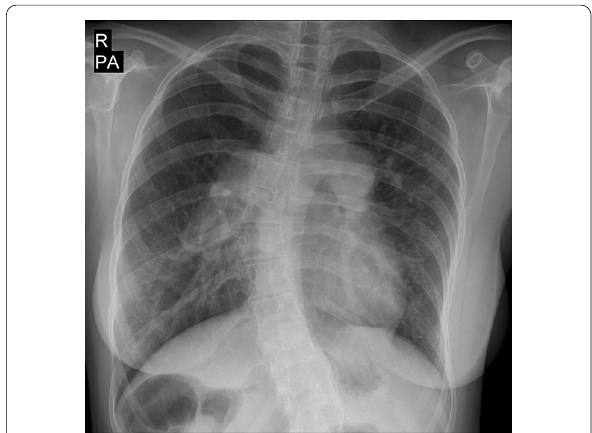
Fig. 1 Chest X‑ray showing pulmonary artery dilation, right ventricular enlargement and scoliosis